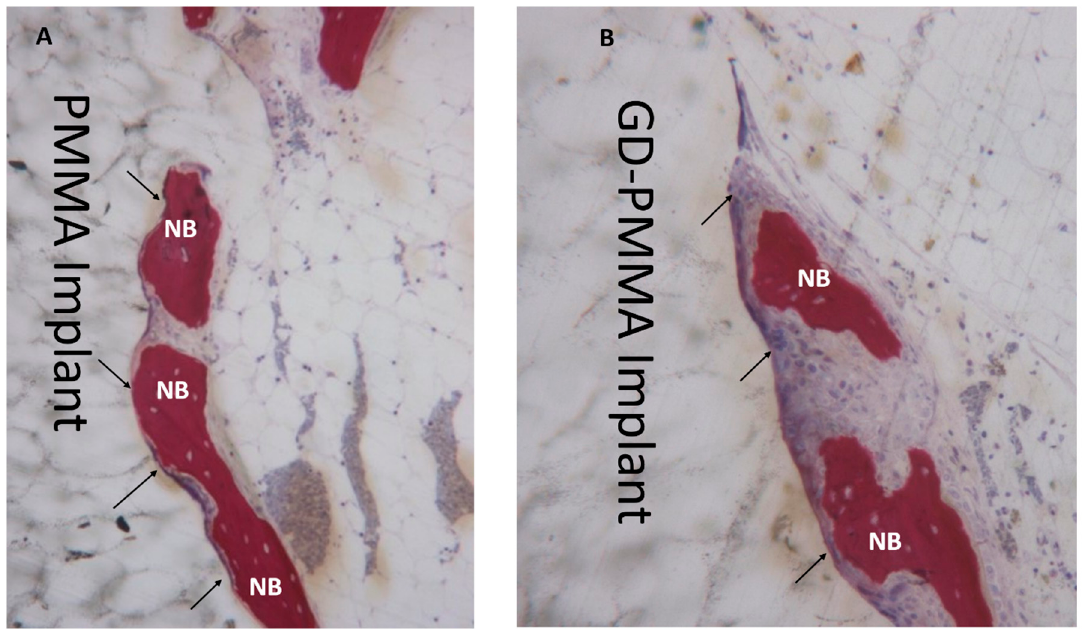
Figure 2. ( A ) PMMA implant. New bone (NB) in direct contact with implant (arrows) is present. Acid fuchsin-toluidine blue 100 × . ( B ) GD-PMMA implant. Osteoblast (arrows) and new bone (NB) in direct contact with the implant. Acid fuchsin-toluidine blue 100 ×